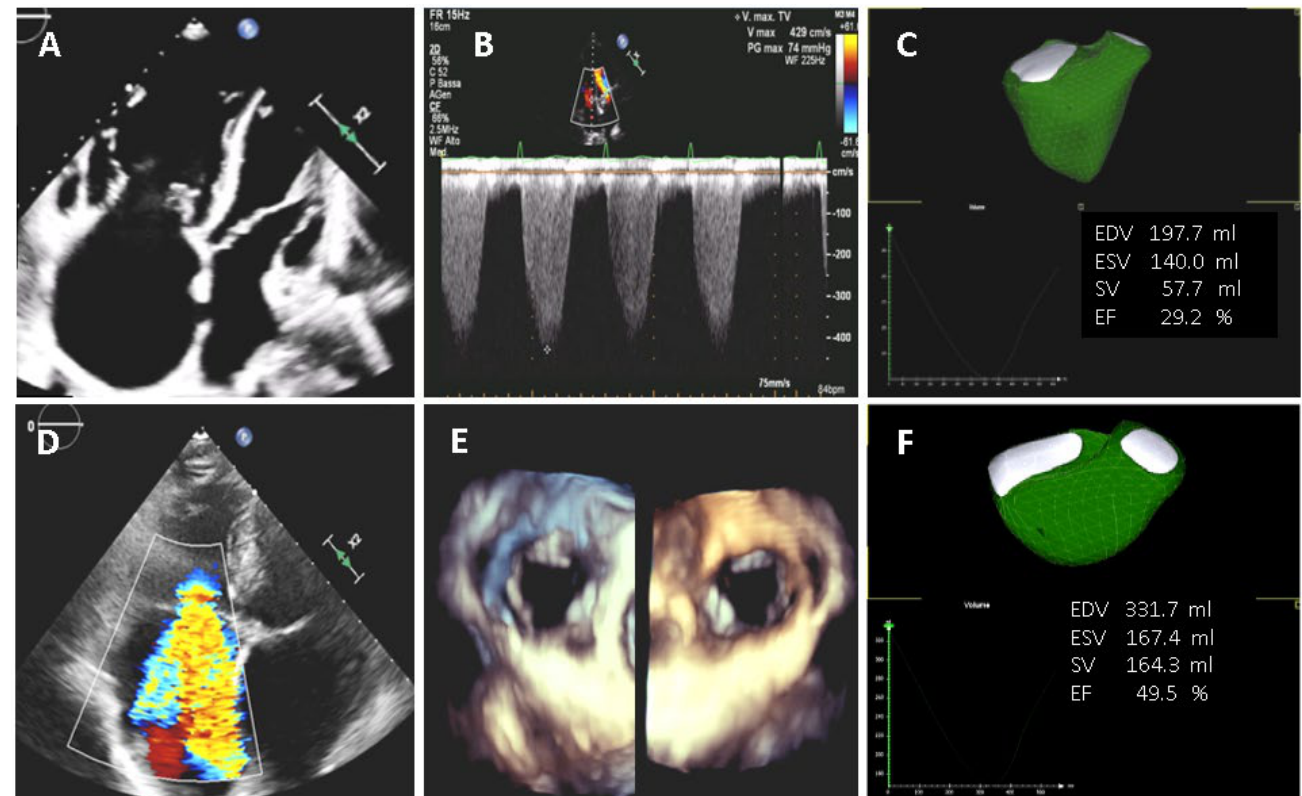
Figure 5. Patient with severe pulmonary hypertension (top panels) and a case with severe volume overload due to tricuspid regurgitation (bottom panels). ( A ) four–chamber view showing severe RV dilation; ( B ) continuous wave Doppler of tricuspid regurgitation indicating severe pulmonary hypertension; ( C ) AI 3D analysis confirms severe dilatation and dysfunction of the RV; ( D ) severe tricuspid regurgitation; ( E ) 3D RV view of the tricuspid valve; ( F ) AI 3D measurements showing RV dilation with normal RV systolic function.